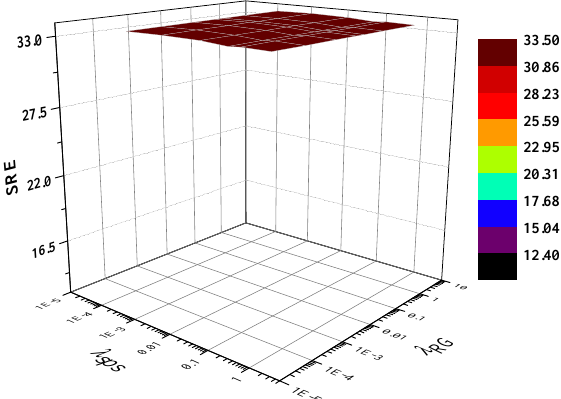
Figure 12. Sensitivity analysis for regularization parameters λ sps and λ RG in RGSU algorithm with simulated dataset 1.